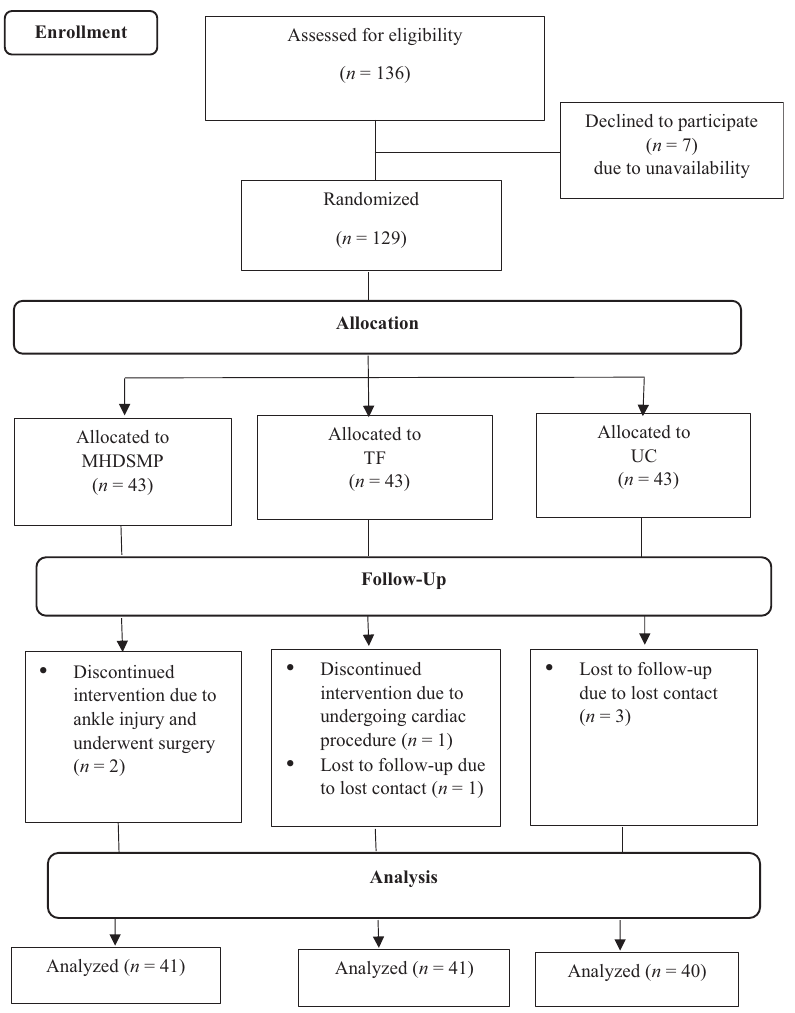
Figure 1. Flow diagram